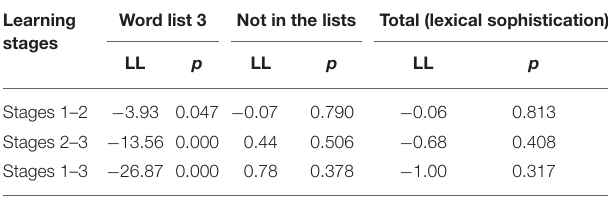
TABLE 2 | Number of word types per word list and per learning